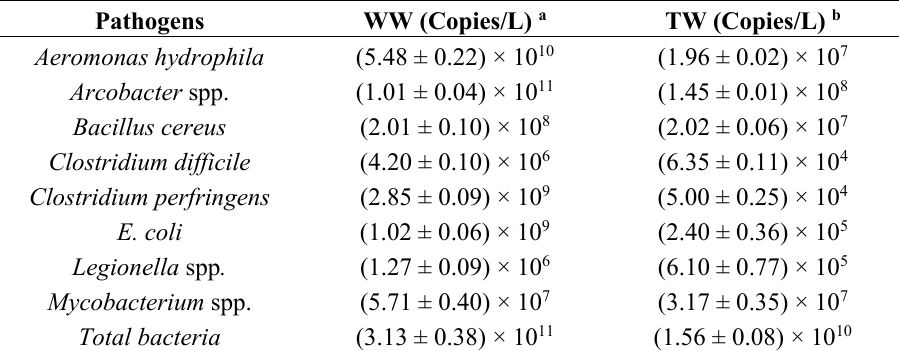
Table 5. Number of pathogens in wastewater and treated